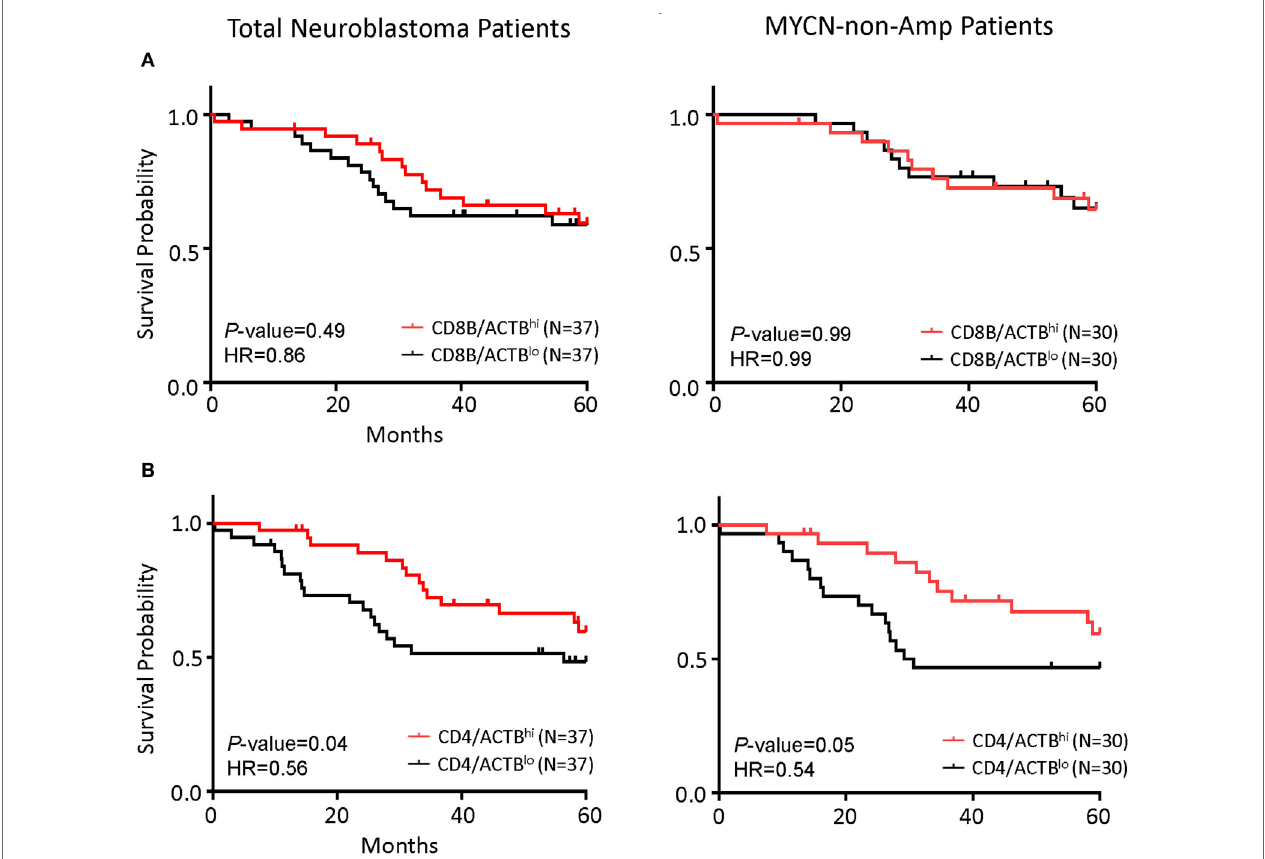
FigUre 3 | CD4 gene expression in the tumor is the principal determinant of prognosis in all patients and in patients with MYCN non-amplified tumors. (a) Kaplan–Meier curves showing 5-year survival of neuroblastoma (NB) patients according to their CD4 gene expression normalized to the ratio of actin expression. Total NB samples (left) and MYCN non-amplified NB samples (right) were divided into CD4/ACTB hi (above the upper quartile) and CD4/ACTB lo (below the lower quartile) groups based on RNA-seq data. (b) Kaplan–Meier curves showing 5-year survival of NB patients according to their CD8B gene expression normalized with the ratio of actin expression. Total NB samples (left) and MYCN non-amplified NB samples (right) were divided into CD8B/ACTB hi (above the upper quartile) and CD8B/ACTB lo (below the lower quartile) groups based on RNA-seq data. The hazard ratio and P -value in (a,b) displayed on the graphs are from the log-rank test and Gehan–Breslow–Wilcoxon